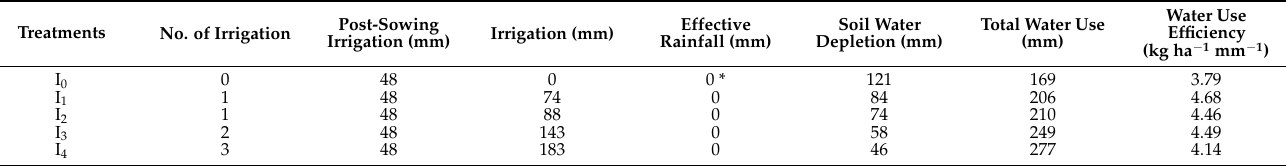
Figure 1. Different irrigation schedules varied soil moisture content at 0–45 cm depth. MC = Moisture content; FC = Field capacity; PWP = permanent wilting point. Table 1. Water use efficiency of mung bean under different irrigation